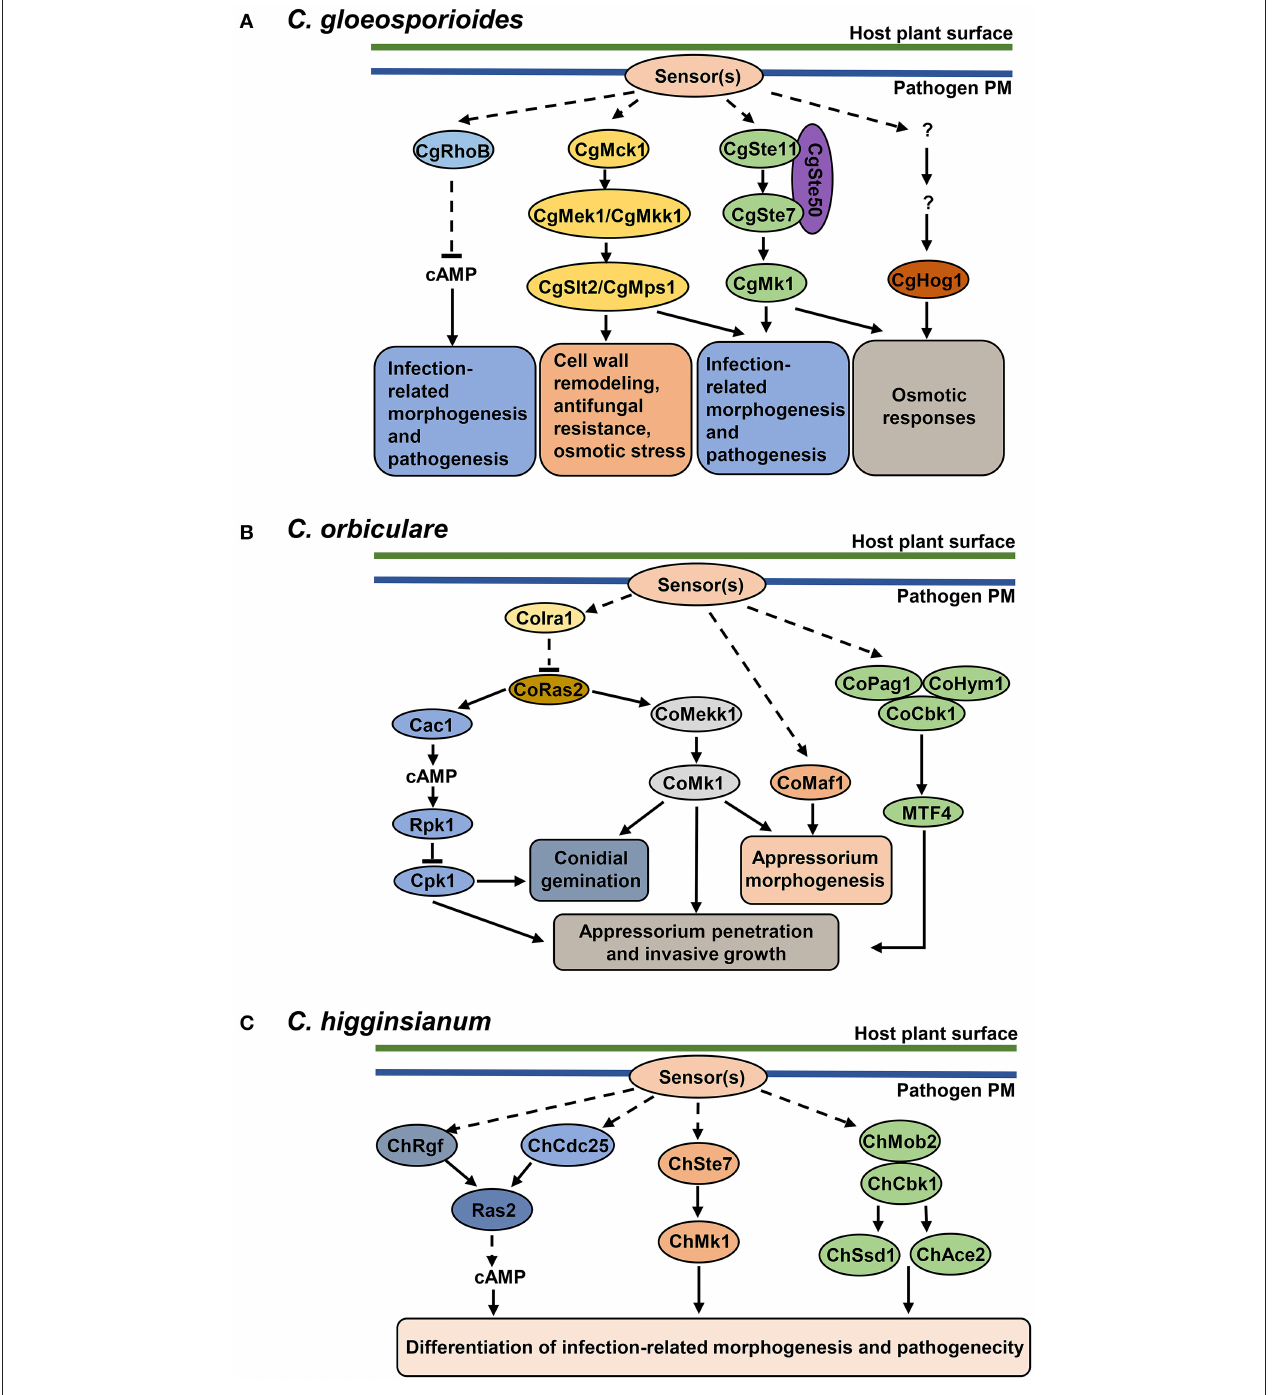
FIGURE 2 | Protein kinase pathways in Colletotrichum pathogens. (B) cAMP signaling pathway, MAPK cascades and MOR pathway in C. orbiculare . cAMP-PKA signaling pathway (adenylate cyclase Cac1, PKA regulatory unit Rpk1, PKA catalytic unit Cpk1) is involved in conidial germination, appressorium penetration and invasive growth. The CoMekk1-CoMk1 module is involved in conidial germination, appressorium formation and penetration. CoMaf1 is involved in appressorium